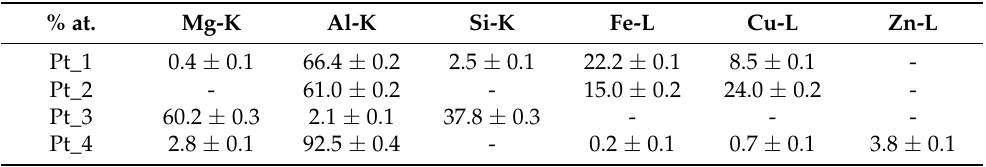
Figure 2. SEM images of intermetallic particles in the 7475 Al alloy: ( a ) SEM image of the CG_T6 sample, ( b ) BSE image of the Al-Cu-Fe particle, ( c ) BSE image of the Mg 2 Si particle, ( d ) SEM image of the HE sample. Table 2. EDS analysis of the chemical composition of secondary phases present in the 7475 Al alloy (points 1-4 in Figure 3) .